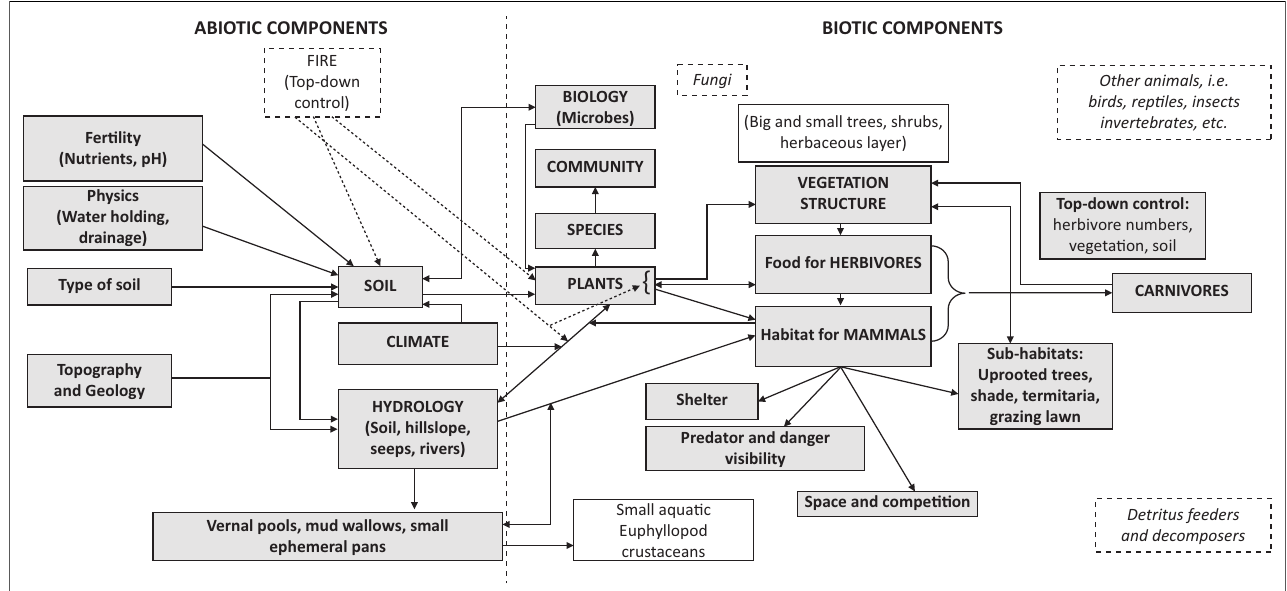
FIGURE 1: Links between abiotic and biotic components of the savanna granitic catena ecosystem. Ecosystem components that did not form part of this study are indicated in dotted line blocks, but only fire has been linked to other components. A connection to soil or plants implies its sub-components as